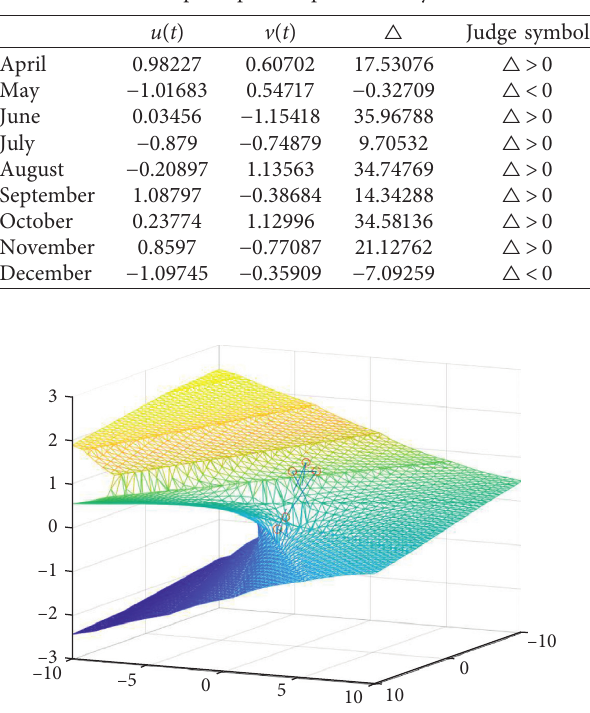
Table 4: The principal component analysis in 2018.